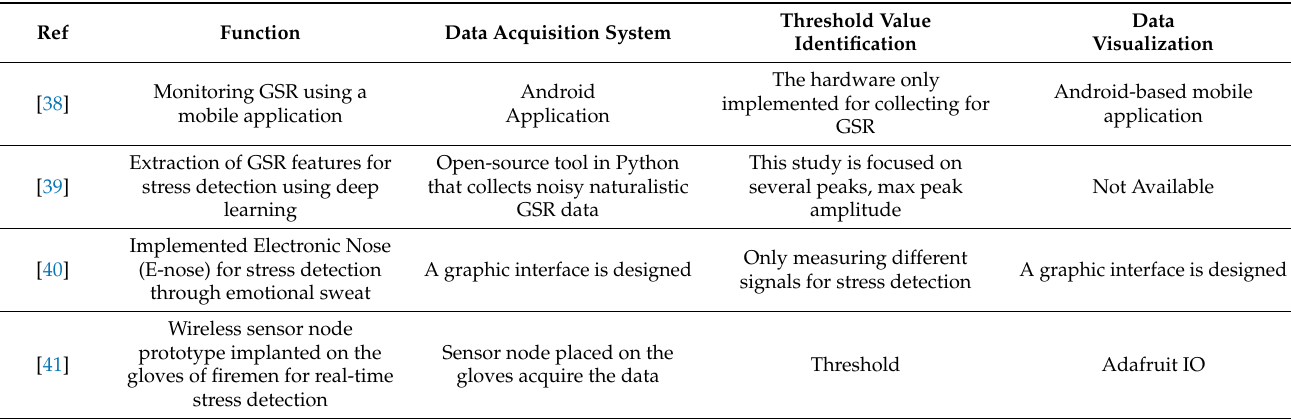
Table 1. Comparison with previous studies.